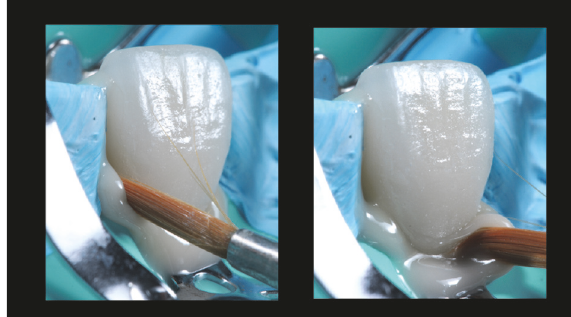
Figure 18: Light curing of the ceramic in position.